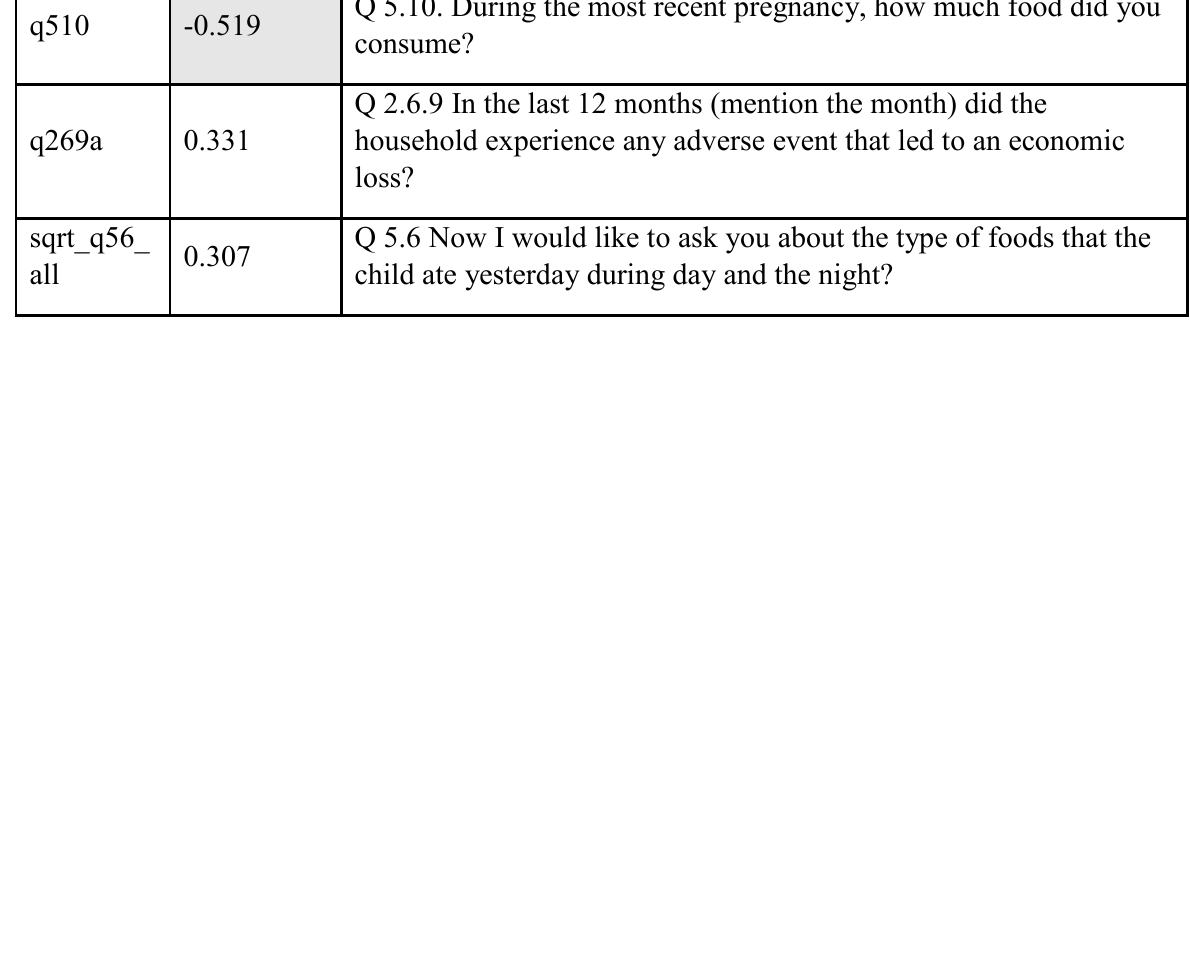
Table 1.22: Variables defining Absorptive Resilience PC11